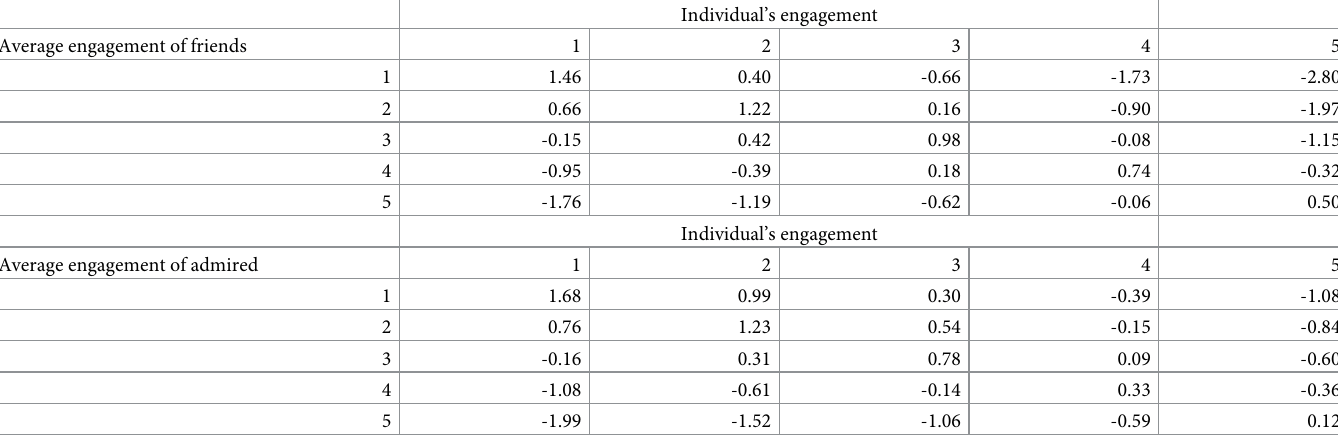
Table 5. Ego-alter influence: Influence of friends and admired peers (alters) on adolescents’ (egos’)